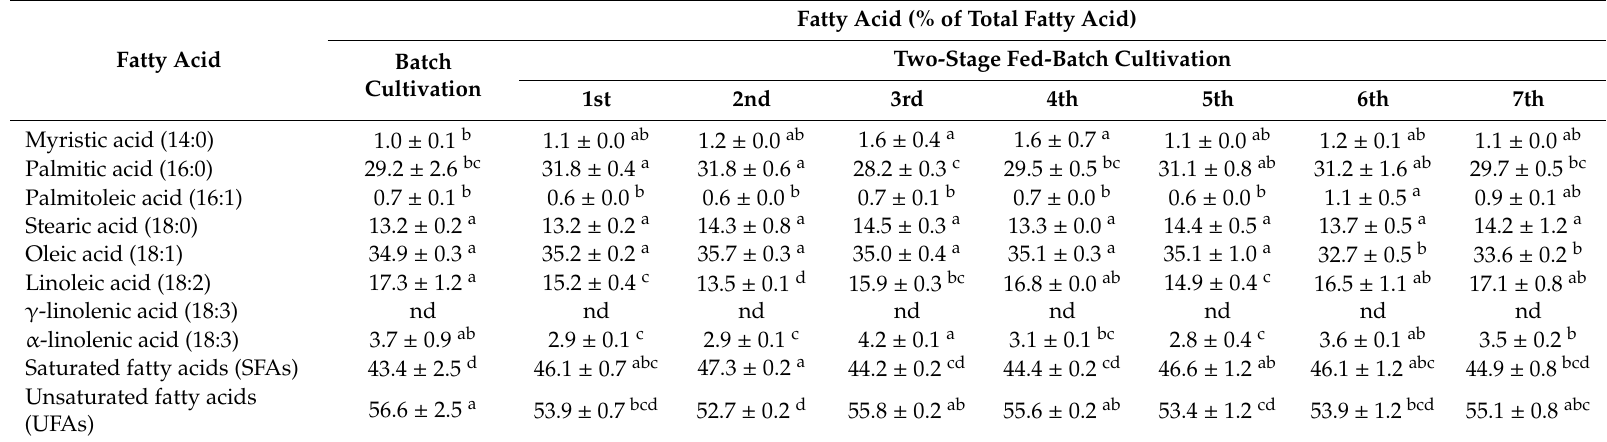
Table 4. Fatty acid profiles of lipid produced by Rhodosporidiobolus fluvialis DMKU-SP314 using two-stage fed-batch cultivations with di ff erent feeding strategies. Fatty Acid (% of Total Fatty Acid) Fatty Acid Batch